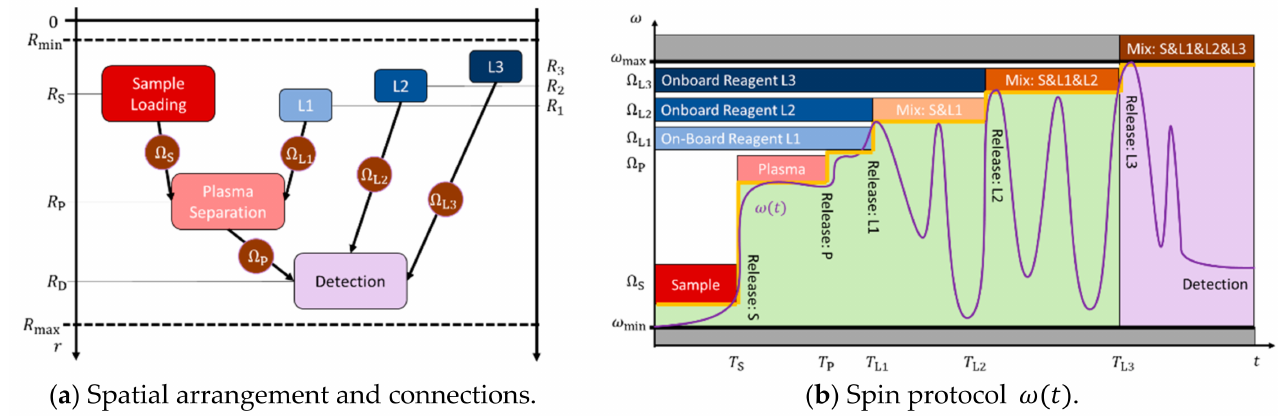
Figure 6. Exemplary bioassay implementing the loading of blood sample, plasma separation, and mixing with three prestored liquid reagents { L i } . Flow is controlled by five high-pass valves with release rates ω min < Ω i < ω max located at R min < R i < R max and opening for ω > Ω i at points in time T i . ( a ) Plasma (P) is extracted from the sample (S) in a peripheral position R P at high field strength f ω ∝ R P · ω 2 (1). While owing to the unidirectional nature of the centrifugal field f ω (1), the course of the assay requires R S < R P < R D and R L1 < R P , a radially inbound staggering R L1 > R L2 > R L3 (Figure 5b) has been chosen for the serial release of { L i } through their high-pass valves opening at Ω L1 < Ω L2 < Ω L3 . ( b ) A blood sample S is loaded and released at Ω S < ω < Ω P . Separation of plasma P proceeds at Ω P < ω < Ω L1 . Onboard liquid reagent L1 is then forwarded at Ω L1 < ω < Ω L2 into the separation chamber where it is mixed with the plasma P within ω min < ω < Ω L2 . The mixture P&L1 then progresses to the final detection chamber for Ω P < ω < Ω L2 , followed by addition of and mixing with L2 within Ω 2 < ω < Ω 3 and ω min < ω < Ω L3 , respectively. Finally, L3 is added at Ω 3 < ω < ω max and blended to obtain S&L1&L2 within ω min < ω < ω max . The green background marks the allowed frequency corridor at each point in time t = T i , with its upper limit expanding according to ω min < Ω S < Ω P < Ω L1 < Ω L2 < Ω L3 < ω max . Note that, for the sake of simplicity, the frequency thresholds { Ω i } are meant to refer to their associated bands Ω i ± M · ∆Ω i